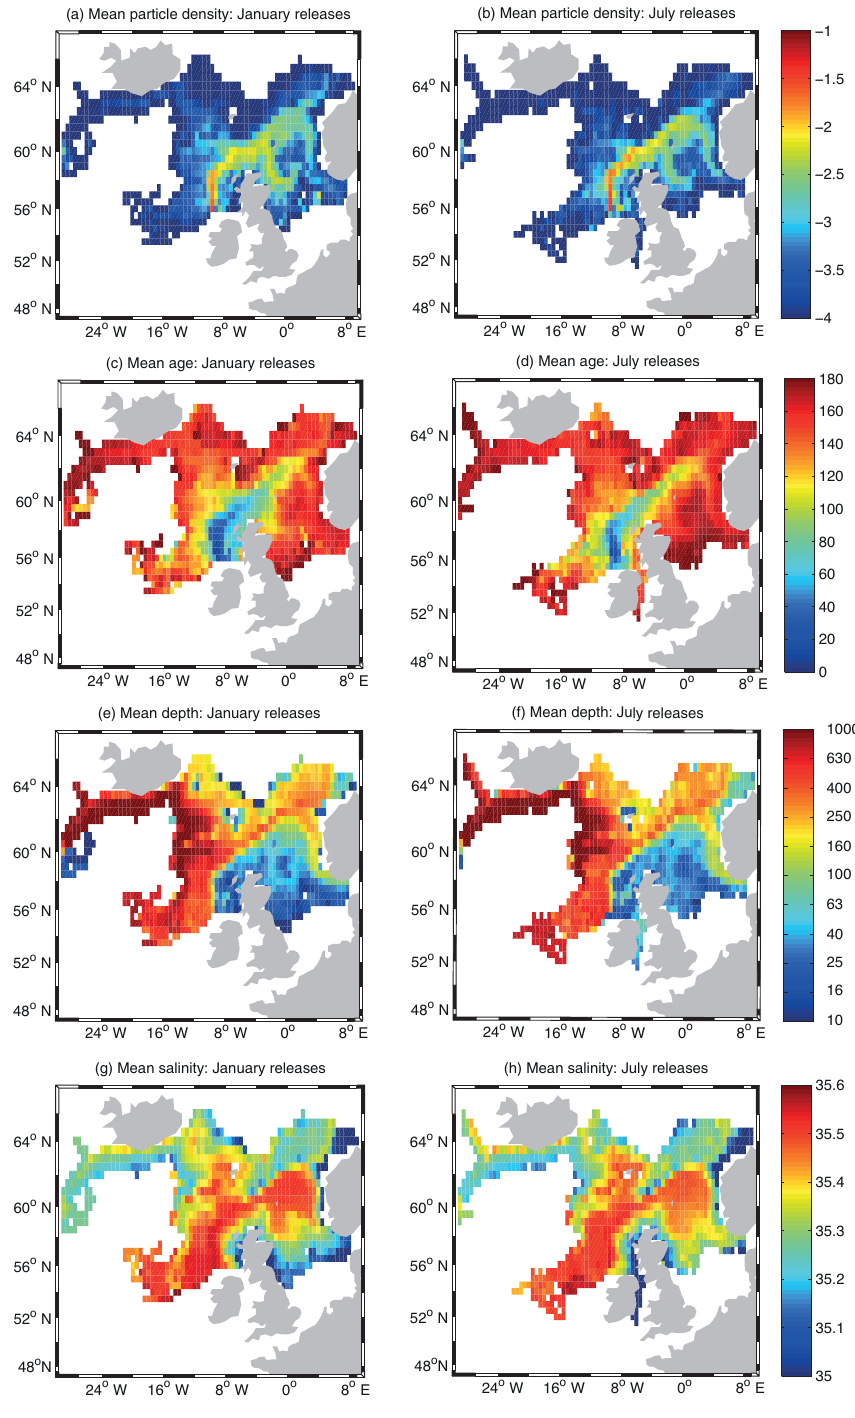
Figure 2. Forward trajectories from the FASTNEt release section in ORCA12-N01, for particles released on 1 January and 1 July: (a, b) mean particle density; (c, d) mean particle age (days since 1 January or 1 July); (e, f) mean particle depth (m); (g, h) mean particle salinity (psu). Averages are for 1988–2007, and values are binned at 0.5 ◦ × 0.5 ◦ resolution. Particle density is expressed as a fraction, obtained as the number of particle occurrences per 0.5 ◦ × 0.5 ◦ grid cell divided by the total number of particle occurrences. The logarithmic scale for density, ranging from − 4 to − 1, equates to 0.01–10% of all particle